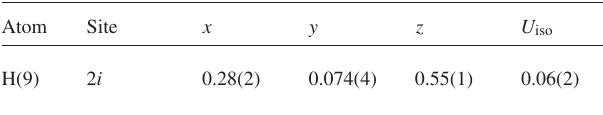
Table 2. Atomic coordinates and displacement parameters (in Å 2 )